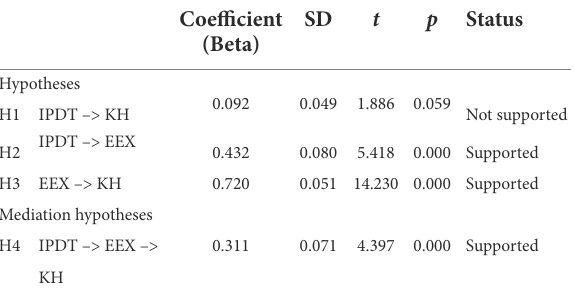
TABLE 5 Hypotheses testing